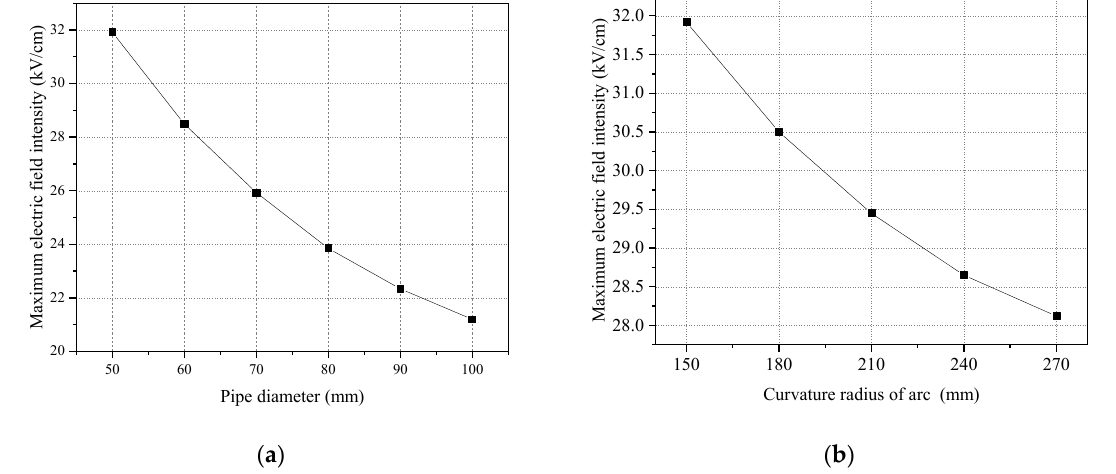
Figure 4. MEI on the saddle type grading ring surface with different pipe diameters and curvature radiuses of arc. ( a ) The MEI on the grading ring surface with different pipe diameters; ( b ) The MEI on the grading ring surface with different curvature radiuses of arc.